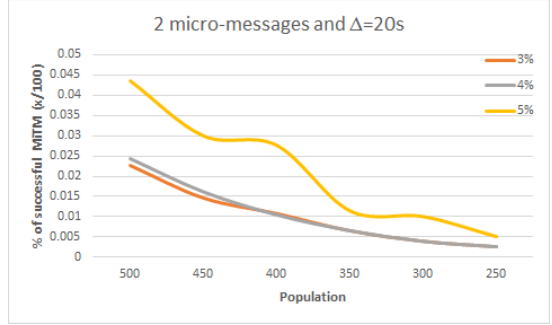
Figure 7. Percentage of successful M i TM when ∆ is